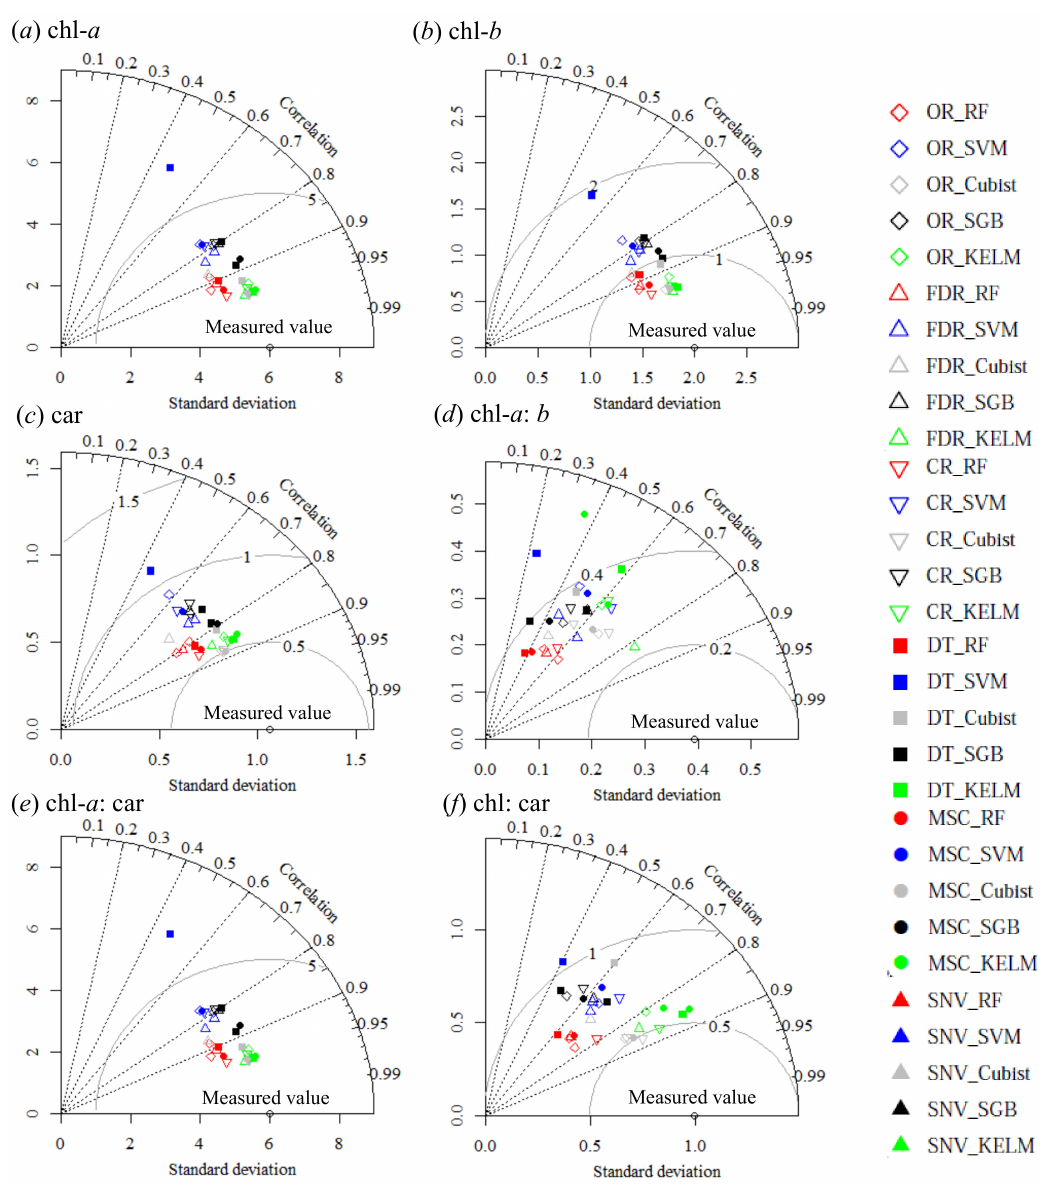
Figure 5. Taylor diagrams showing the performance of the regression models based on machine learning algorithms and ( a ) chl a , ( b ) chl b , ( c ) car, ( d ) chl a :b, ( e ) chl a :car, or ( f ) chl:car. The grey counter indicates the root-mean-square error (RMSE) values; OR: original reflectance; FDR: first derivative reflectance; CR: continuum removal; DT; detrending; MSC: multiplicative scatter correction; SNV: standard normal variate; RF: random forest; SVM: support vector machine; SGB: Stochastic Gradient Boosting; and KELM: kernel-based extreme learning machine. The estimated values of KELM were generally closest to the measured values among the five algorithms. Estimated values are also provided as Supplementary